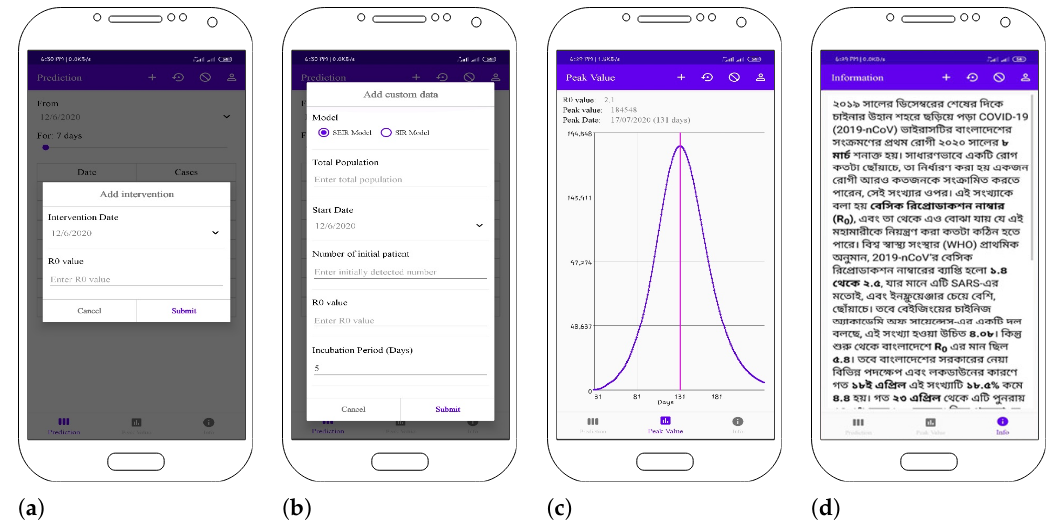
Figure 5. ( a ) Adding an intervention. ( b ) Simulating with custom data. ( c ) Peak value visualization. ( d ) General